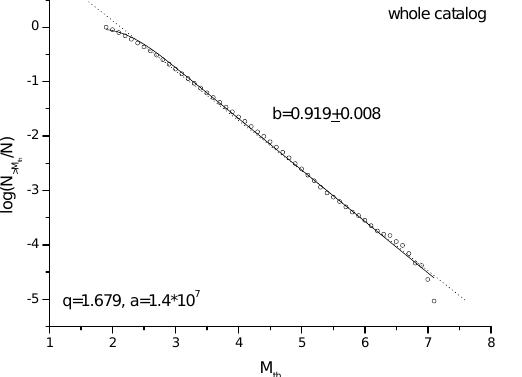
Fig. 2. Normalized cumulative magnitude distribution of the crustal Taiwanese seismicity (open circles) and fitting curve (solid line). The values of the parameters are q =1.679 and a =1.4 × 10 7 . The dot- ted line indicates the Gutenberg-Richter relationship, with b =0.919.